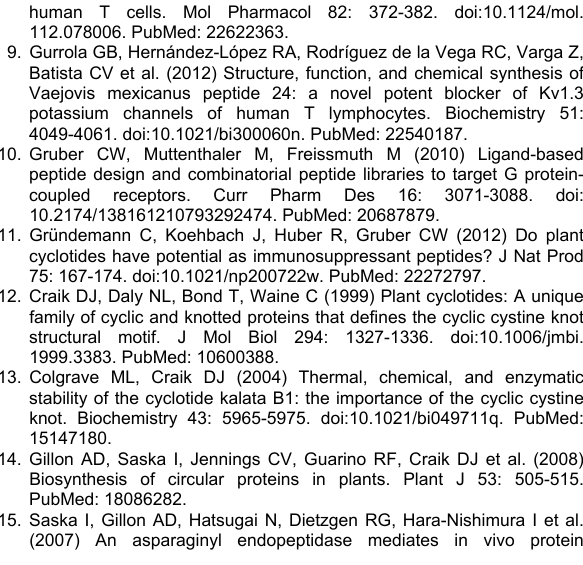
Figure S3. Effects of a cyclotide all-D-enantiomer on cell proliferation of primary activated human lymphocytes and purified T-cells. The influence of medium (ctrl), or kalata B2 and its all-D-enantiomer (D-kalata B2) at various concentrations (1.8-7 µM) on proliferation of activated primary lymphocytes ( A ) and purified T-cells ( B ) was measured by cell division analysis using CFSE-based flow cytometry on day three post stimulation. Data are presented as mean ± SD of three independent donors and experiments (* P <0.05; n.s. not significant).